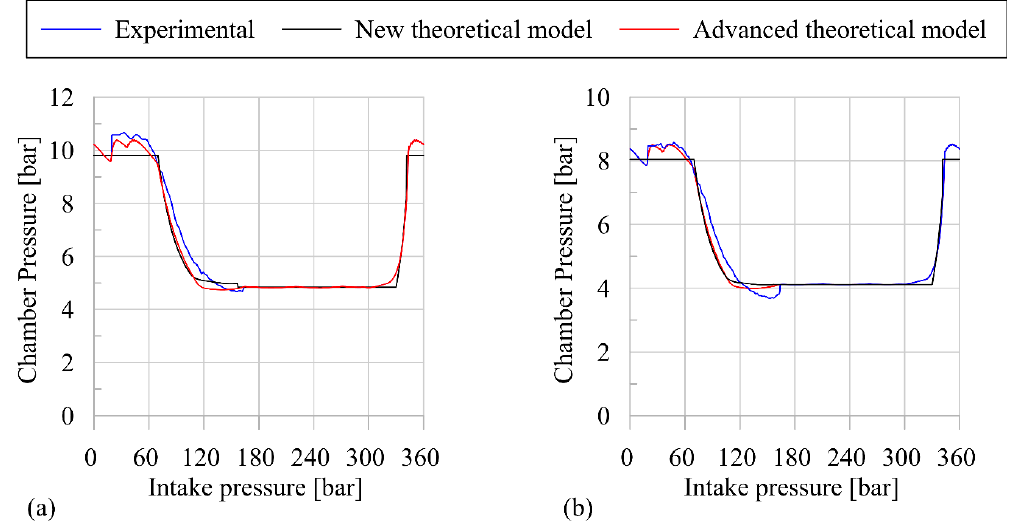
Figure 6. Comparison between experimental, theoretical, and numerical indicated cycle for an intake pressure equal to 10.2 ( a ) and 8.5 ( b ).